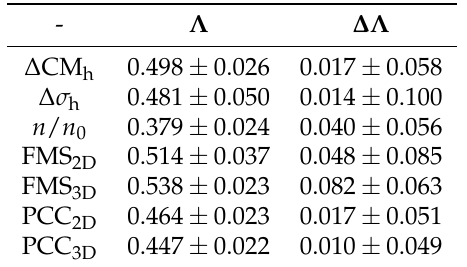
Table 3. The exponent Λ (day − 1 ) and the error of the exponential fits to the curves ∆ CM h , ∆ σ h